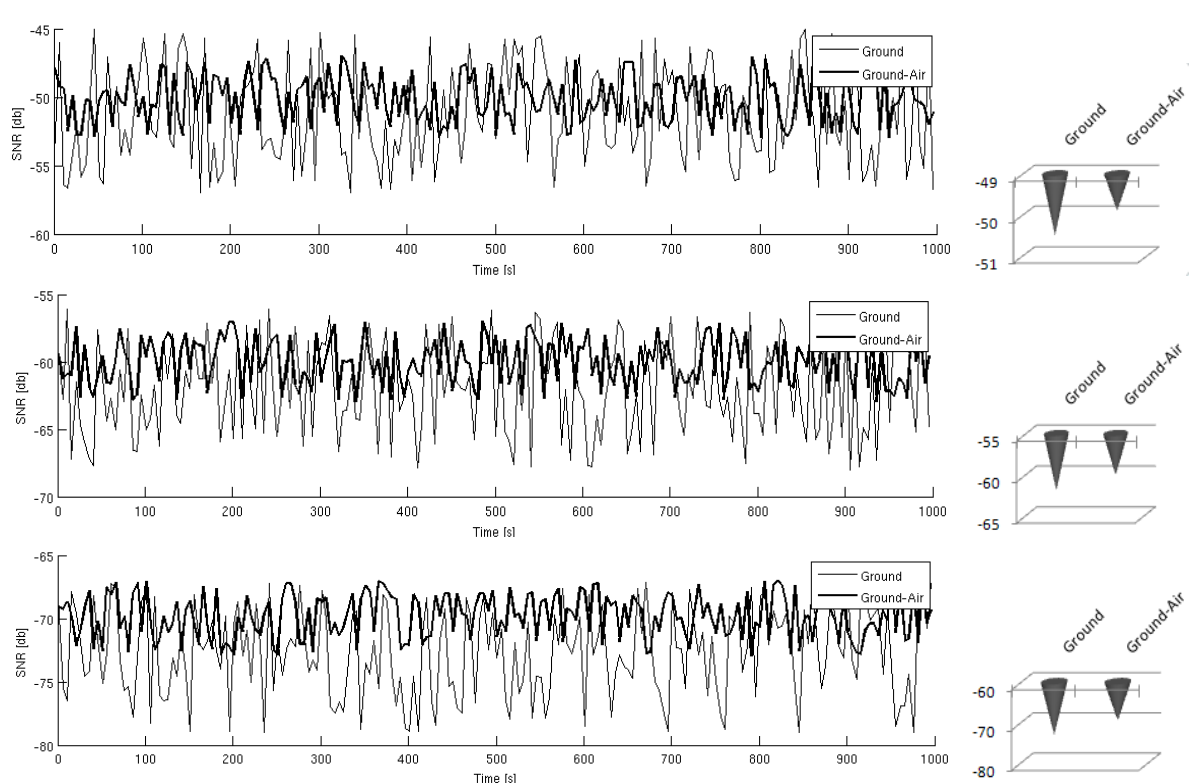
Figure 13. Average SNR obtained for the WSNs from each parcel. From top to down, A, B, C, respectively.